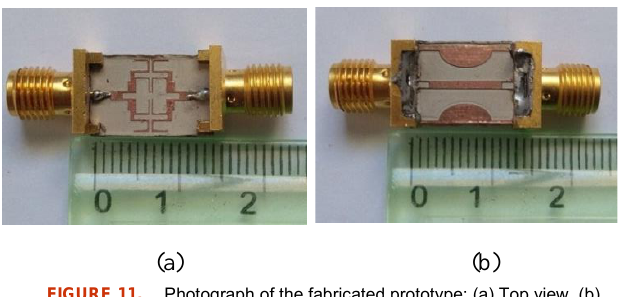
FIGURE 11. Photograph of the fabricated prototype: (a) Top view, (b) bottom view.